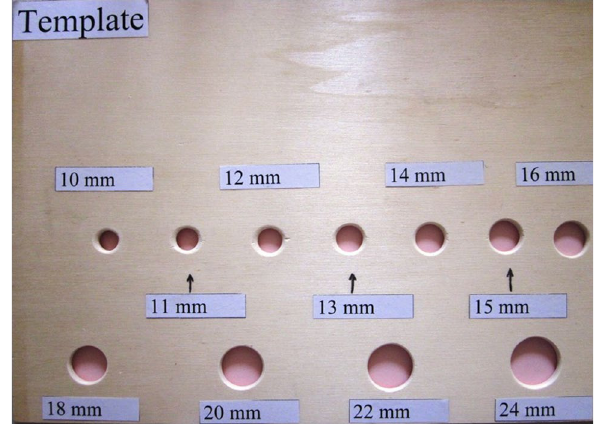
Figure 2. Wooden template.